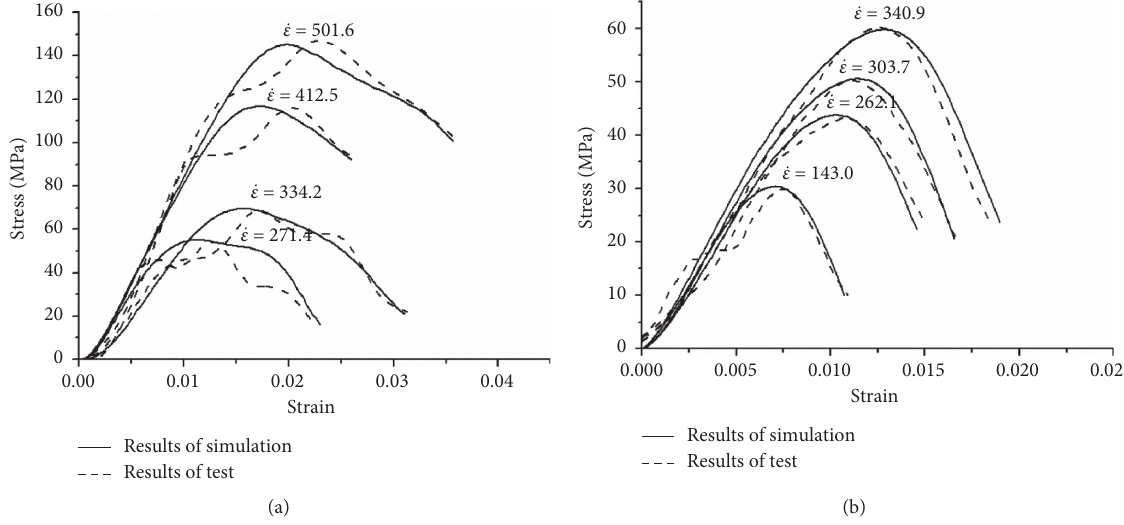
Figure 6: Comparison between the numerical simulation and test results. (a) Impact compression. (b) Impact split.